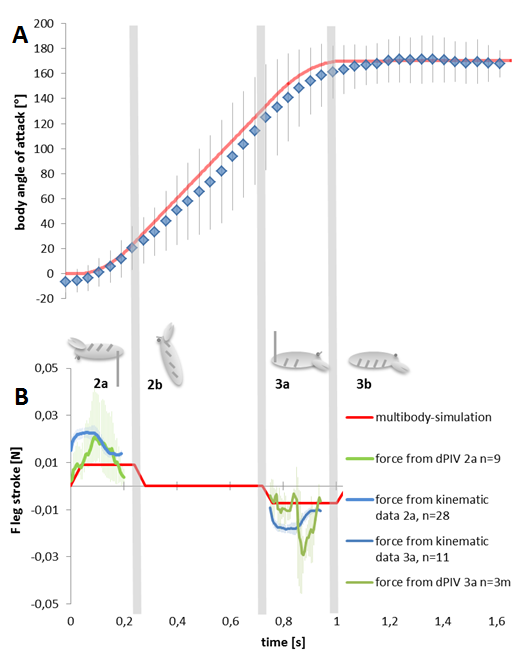
Figure 3. Results from experiment and multibody- simulation for A: body angle and B: induced forces. Experimental forces are mean values of the force calcu- lations. Body angle of experimental data (blue rhomb), n=8 and multibody-simulation (red line) are showing the same trend in time and angle. The calculated forces are 1.5 to 2 times higher (PIV: 2a n=9, 3a n=3, Kinematic: 2a n=28, 3a n=11) than the forces used in the